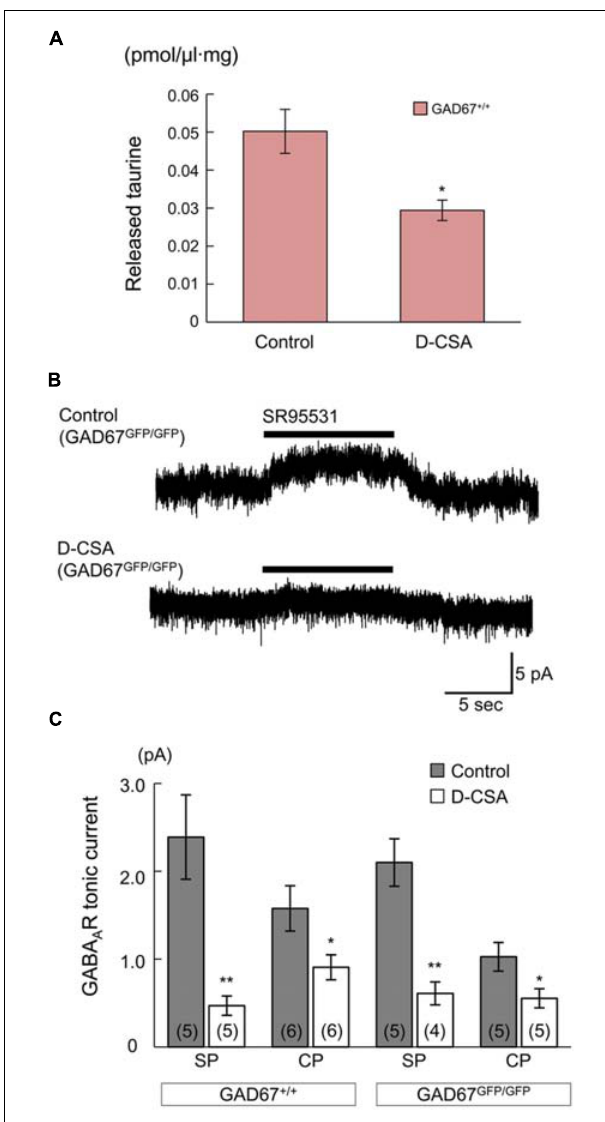
FIGURE 8 | Effects of maternal D-CSA administration on ambient taurine levels and GABA A R-mediated tonic currents in the fetal neocortex. (A) Ambient taurine levels in fetal cortical slices determined via HPLC. E17.5 GAD67 + / + fetuses were obtained from pregnant mice injected with either saline (Control, n = 5) or D-CSA ( n = 5). (B) Typical traces of GABA A R-mediated tonic currents recorded in RFP-positive neurons in the SP regions of GAD67 GFP / GFP fetal cortical slices.The fetuces were obtained from saline- (upper trace) and D-CSA-treated (lower trace) pregnant GAD67 + / GFP mice. (C) Averaged tonic current amplitudes in the SP and the CP regions of cortical slices obtained from GAD67 + / + (left bar group) and GAD67 GFP / GFP (right bar group) fetuses either without (gray bars) or with (white bars) maternal D-CSA injection.The numbers in parentheses indicate the number of samples. * P < 0.05, ** P < 0.01. Error bar: mean ±